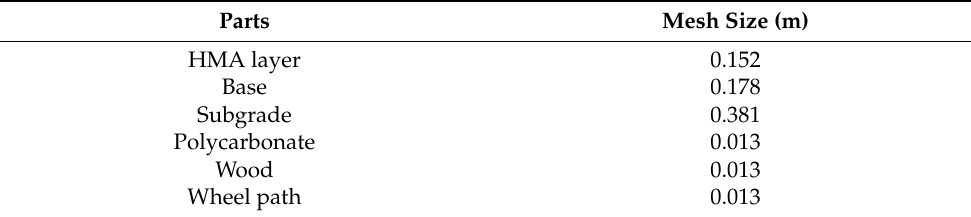
Table 6. Mesh size used in the